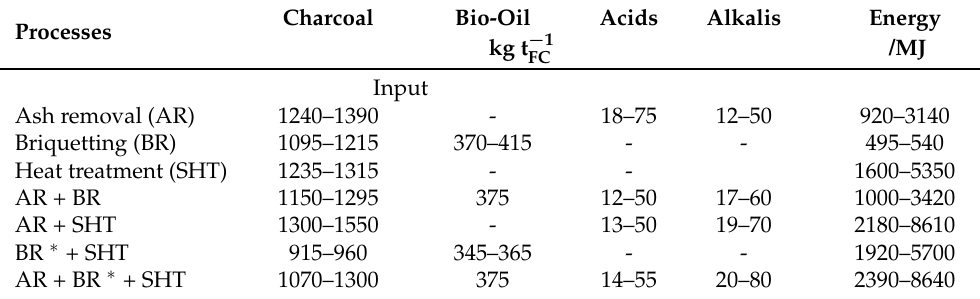
Table 6. Mass and energy demand for the different process routes for ash free charcoal, briquettes and renewable coke on the basis of 1 t FC.